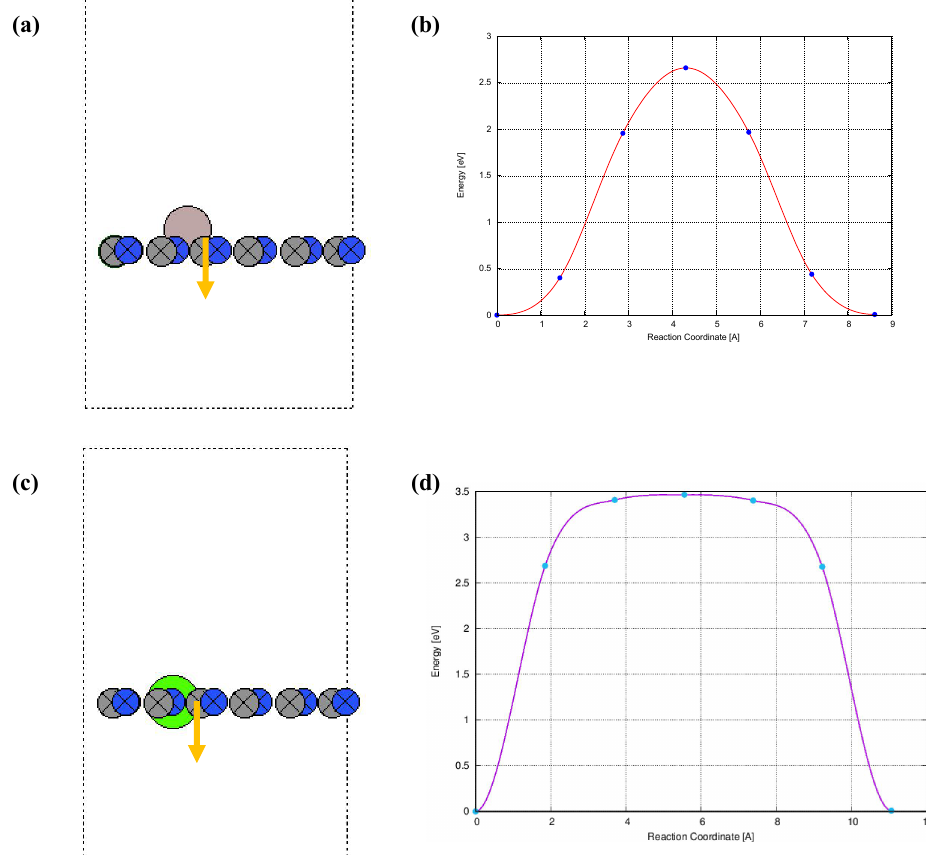
Figure 8. ( a ) The migration of one Al atom within one pore of g-C energy path of the escape mechanism of one Al atom from the pore; ( c ) The migration of one Mg atom within one pore of g-C of one Mg atom from the